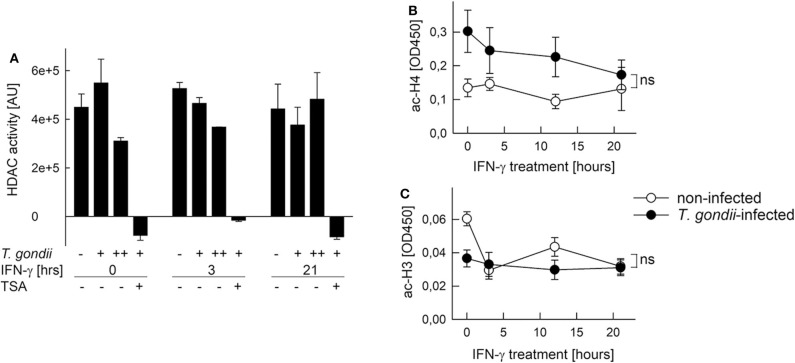
Histone acetylation at IFN-γ-responsive promoters is inhibited by T. gondii without generally impacting HDAC and HAT activities in nuclei of infected cells. RAW264.7 monocytes/macrophages were infected with T. gondii at parasite-to-host cell ratios of 3:1 (A: +) or 6:1 (A: ++; B,C) for 24 h or were left non-infected, and they were stimulated with IFN-γ during the final 3–21 h or left non-stimulated (0 h). (A) HDAC activity was determined in nuclear extracts by measuring deacetylation of a synthetic substrate fluorometrically; some test reactions were performed in presence of the HDAC inhibitor trichostatin A (TSA). Bars represent means ± S.E.M. from two biological replicates. (B,C) Acetylation of synthetic histone H4 (B) and H3 (C) peptides by nuclear extracts was determined by a colorimetric ELISA; data represent means ± S.E.M. (five biological replicates; ns, not significant, ANOVA).